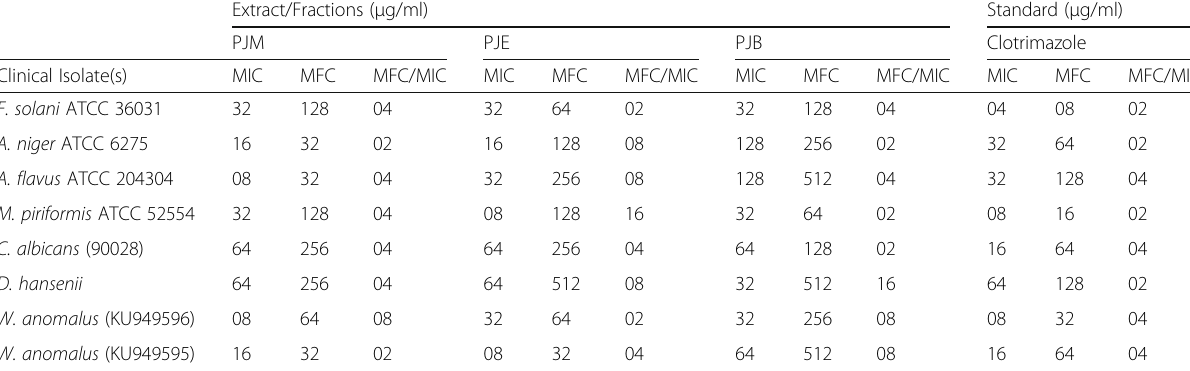
Table 8 Antifungal screening of P. jacquemontiana extracts and clotrimazole Extract/Fractions ( μ g/ml)